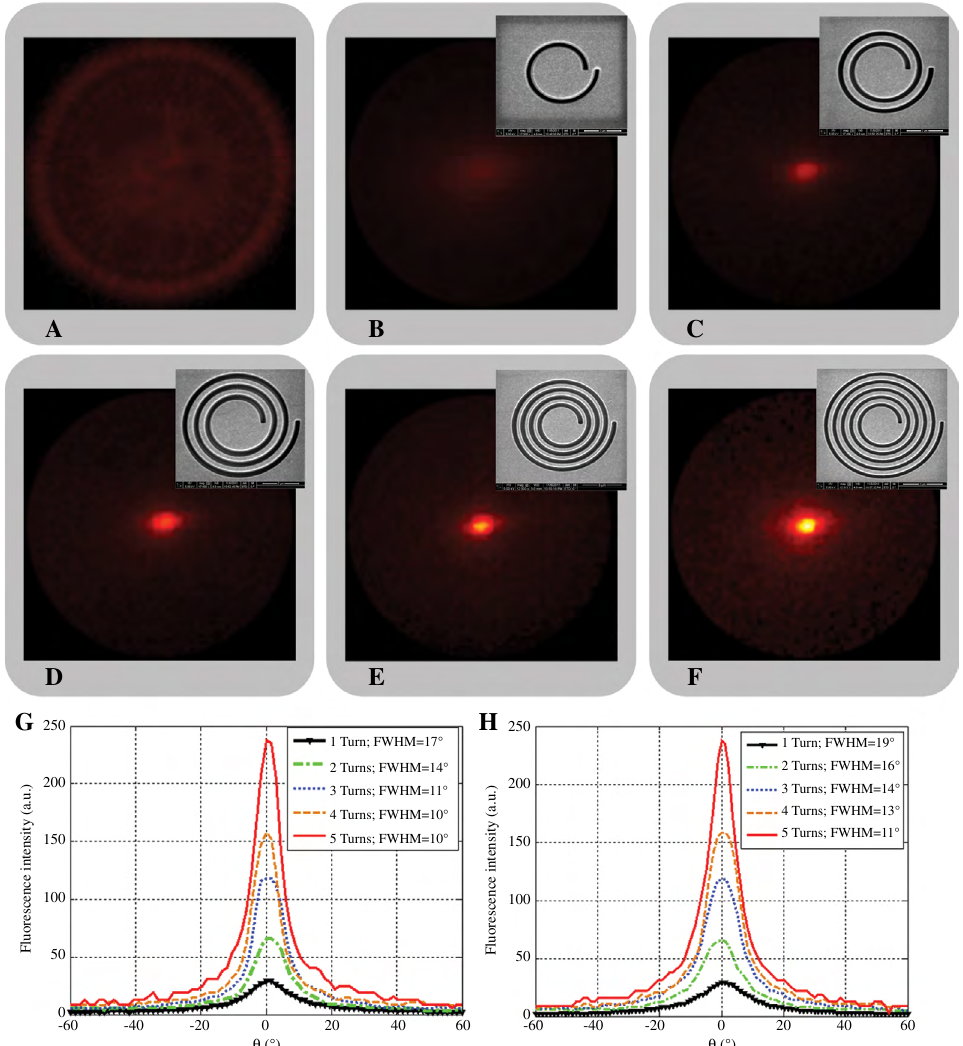
Figure 9 Fluorescence intensity distributions in the back focal plane of a 0.8 NA objective lens for (A) cover slip, and (B)–(F) right handed- ness spiral structure with an increasing number of turns from 1 to 5. SEM images of the spiral antennas are shown in the insets. Line-scans through the center of the emission pattern in the (G) x-z plane and (H) y-z plane. Adapted from Ref. [34].